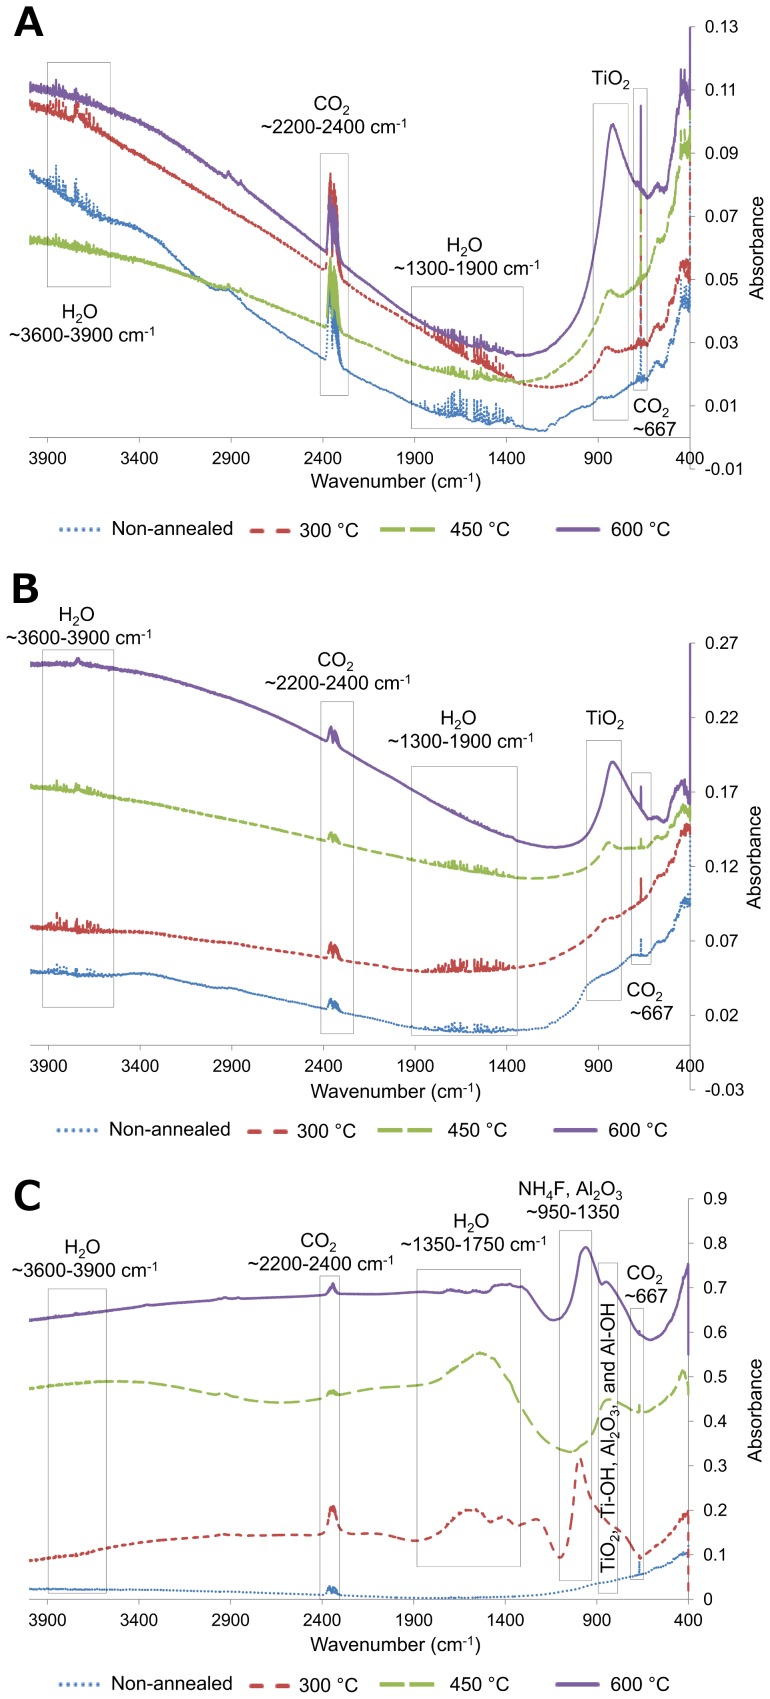
FTIR spectroscopy.FTIR spectra are shown for (A) non-anodized samples, (B) 20 V anodized samples and (C) 60 V anodized samples annealed at different temperatures for 3 h. The obtained spectra confirm the presence of TiO2 along with CO2 and H2O from the FTIR system. As annealing temperature is increased, the intensity of the TiO2 peak is enhanced. In addition, the TiO2 peak shifts from 898 cm−1 for non-annealed samples with amorphous structure to 870 cm−1 for annealed samples at 300 and 450 °C. Finally, the TiO2 peak shifts to 830 cm−1 for the samples annealed at 600 °C.